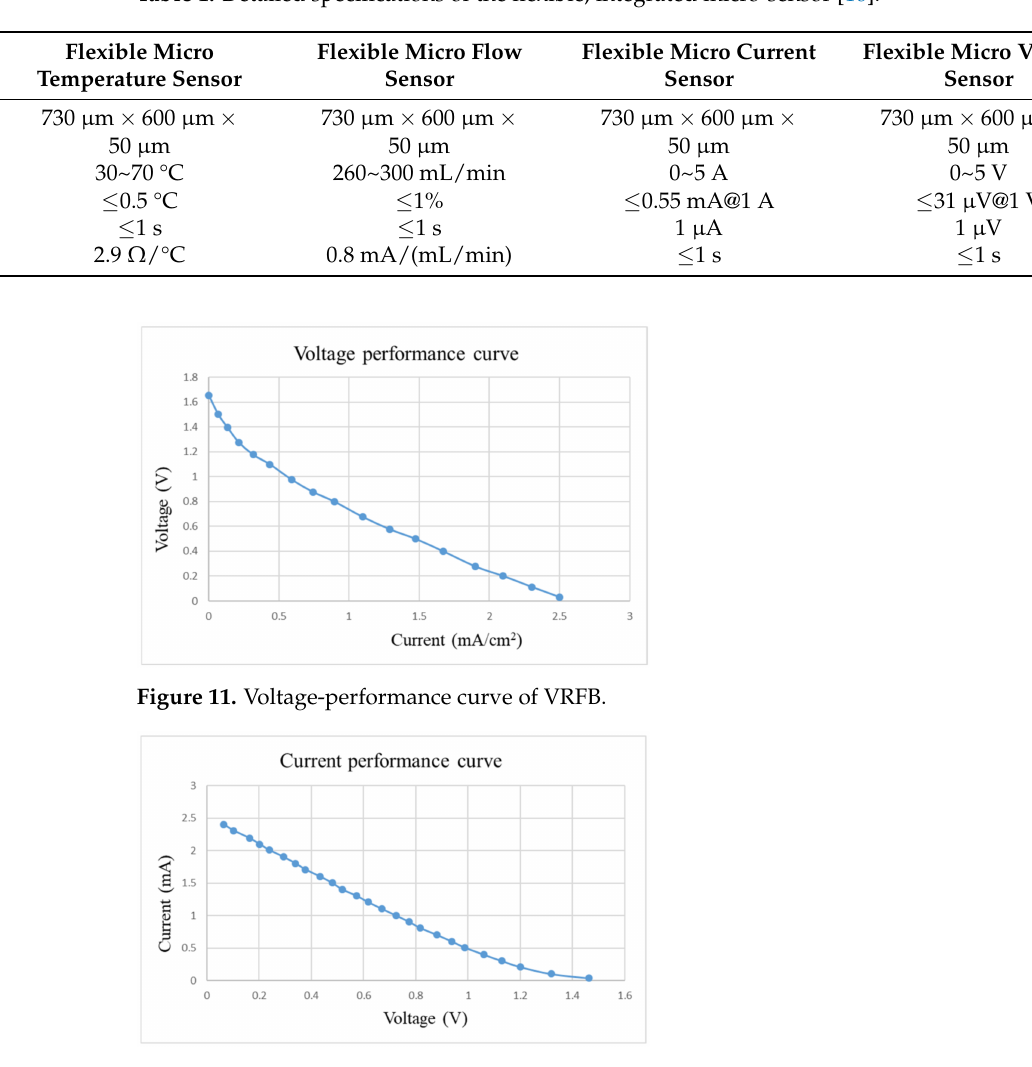
Figure 12. Current-performance curve of VRFB.